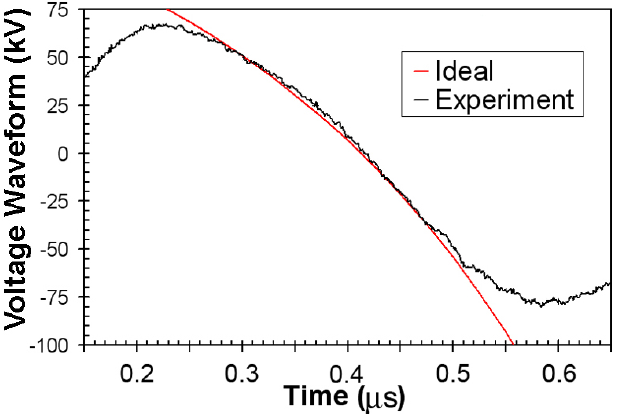
FIG. 8. (Color) Comparison between the experimental voltage waveform (black) and the ideal voltage waveform (red) that would impose an ideal linear velocity tilt on the drifting beam. The axes have been reduced in scale relative to Fig. 3 in order to more clearly illustrate the differences between the two.